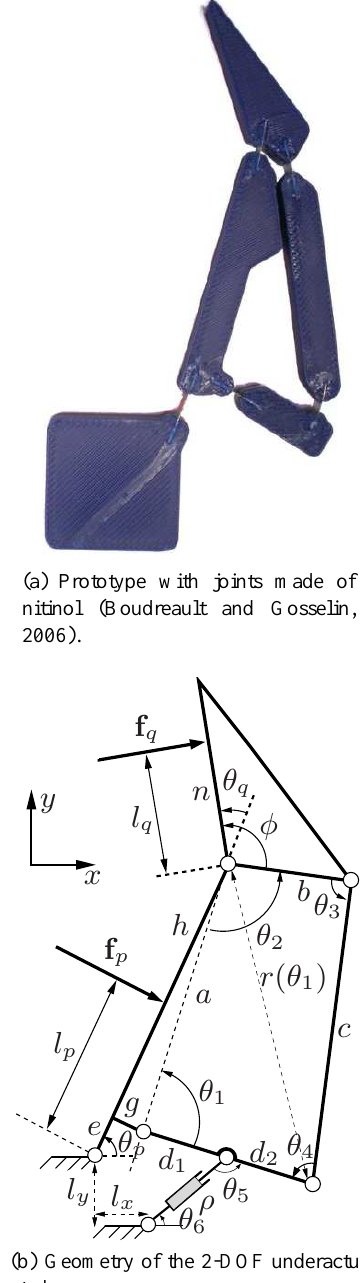
Figure 2. 2-DOF compliant underactuated